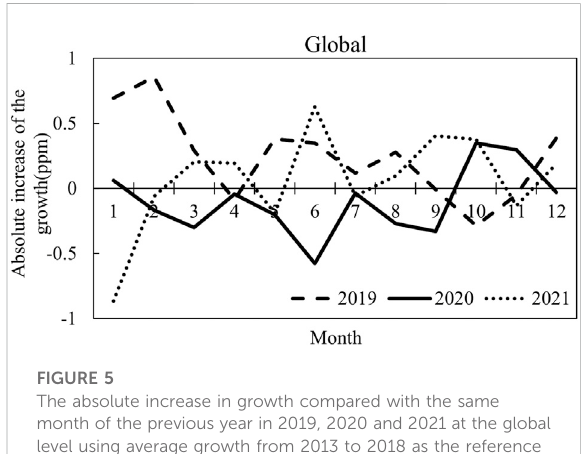
The absolute increase in growth compared with the same month of the previous year in 2019, 2020 and 2021 at the global level using average growth from 2013 to 2018 as the reference